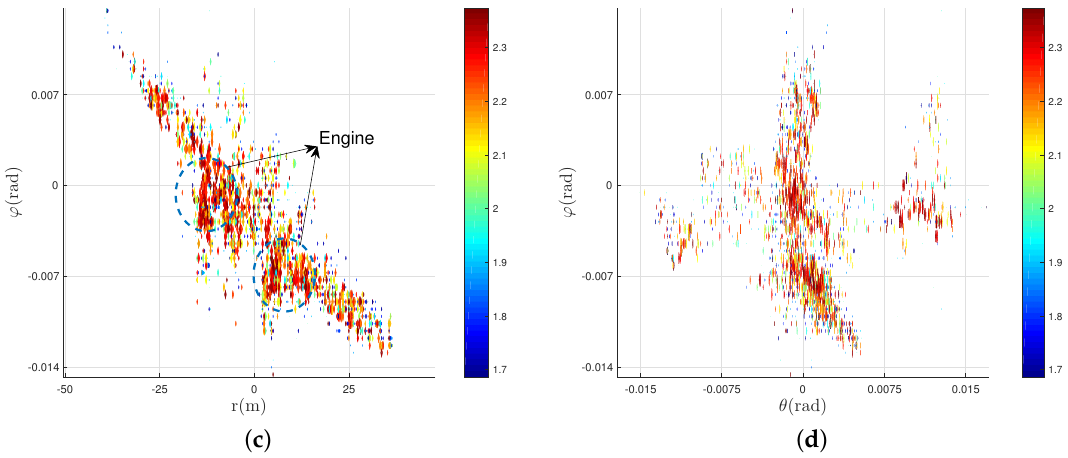
Figure 6. Reconstructed 3D image of the plane by proposed method. ( a ) Overall view of reconstructed result; ( b – d ) 2D projection of the reconstructed 3D